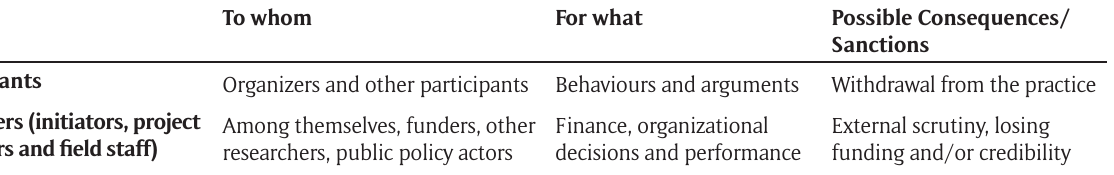
Table 1: Accountability Relations in